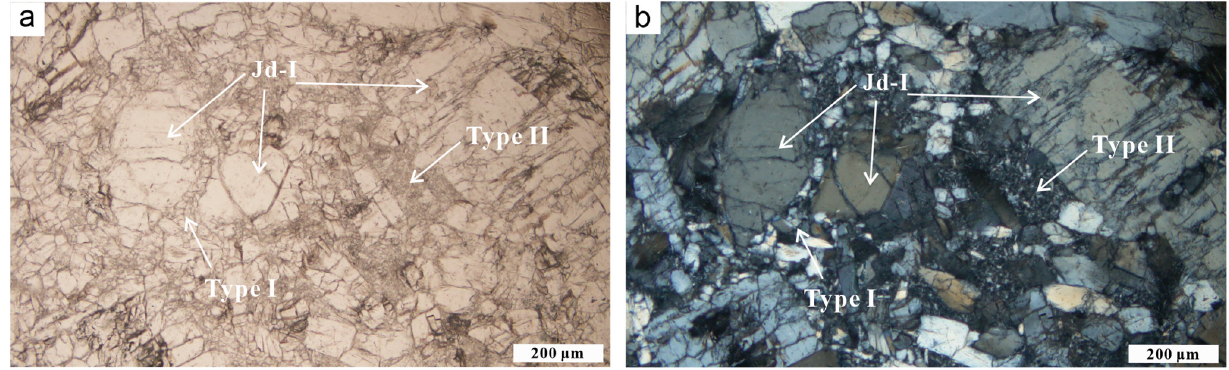
Figure 9. The mixed interstitial textures of the two types can be easily distinguished by grain size (( a ) under plane-crossed polarized light and ( b ) under cross-polarized light) . (( a ) under plane-crossed polarized light and ( b ) under cross-polarized